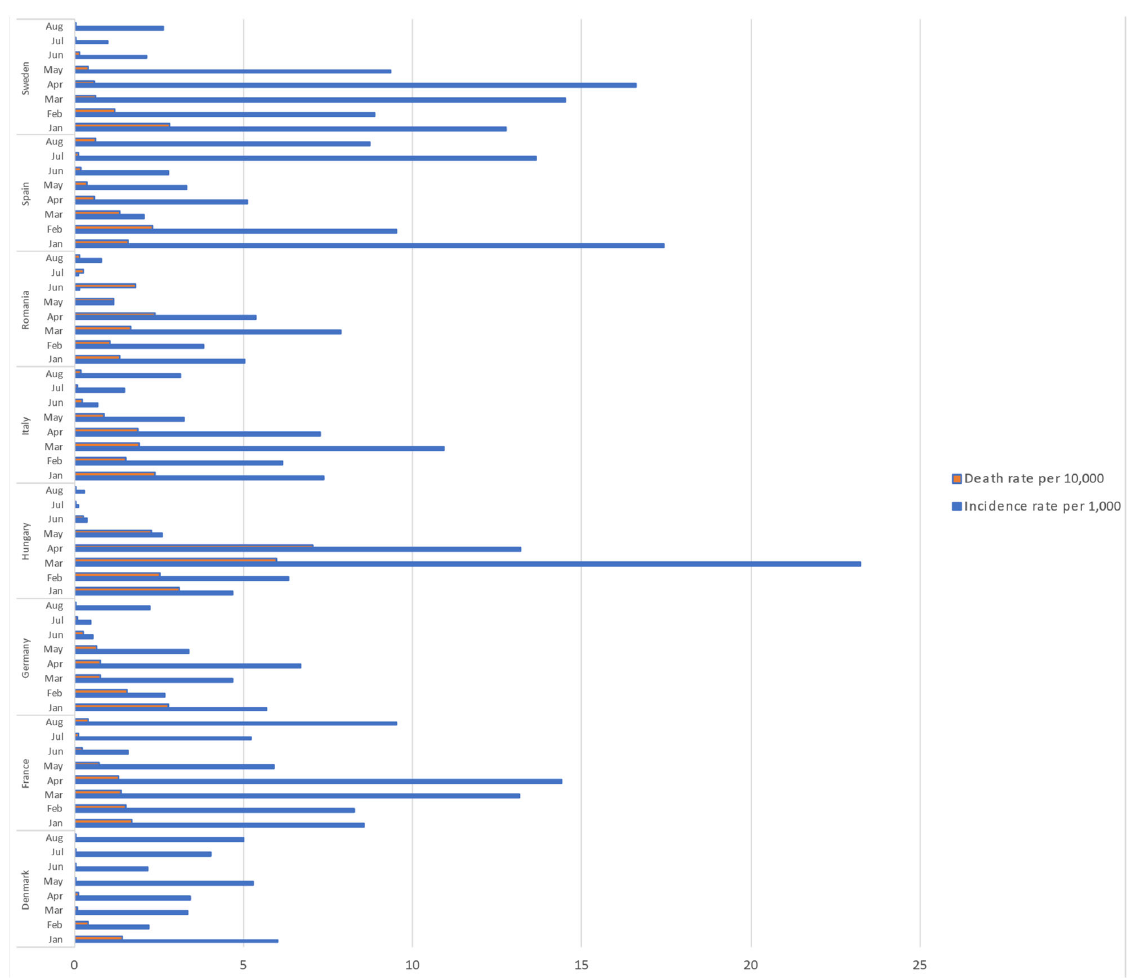
Figure 1. COVID ‐ 19 epidemiology in the eight selected countries. January–August 2021. Figure 1. COVID-19 epidemiology in the eight selected countries. January–August